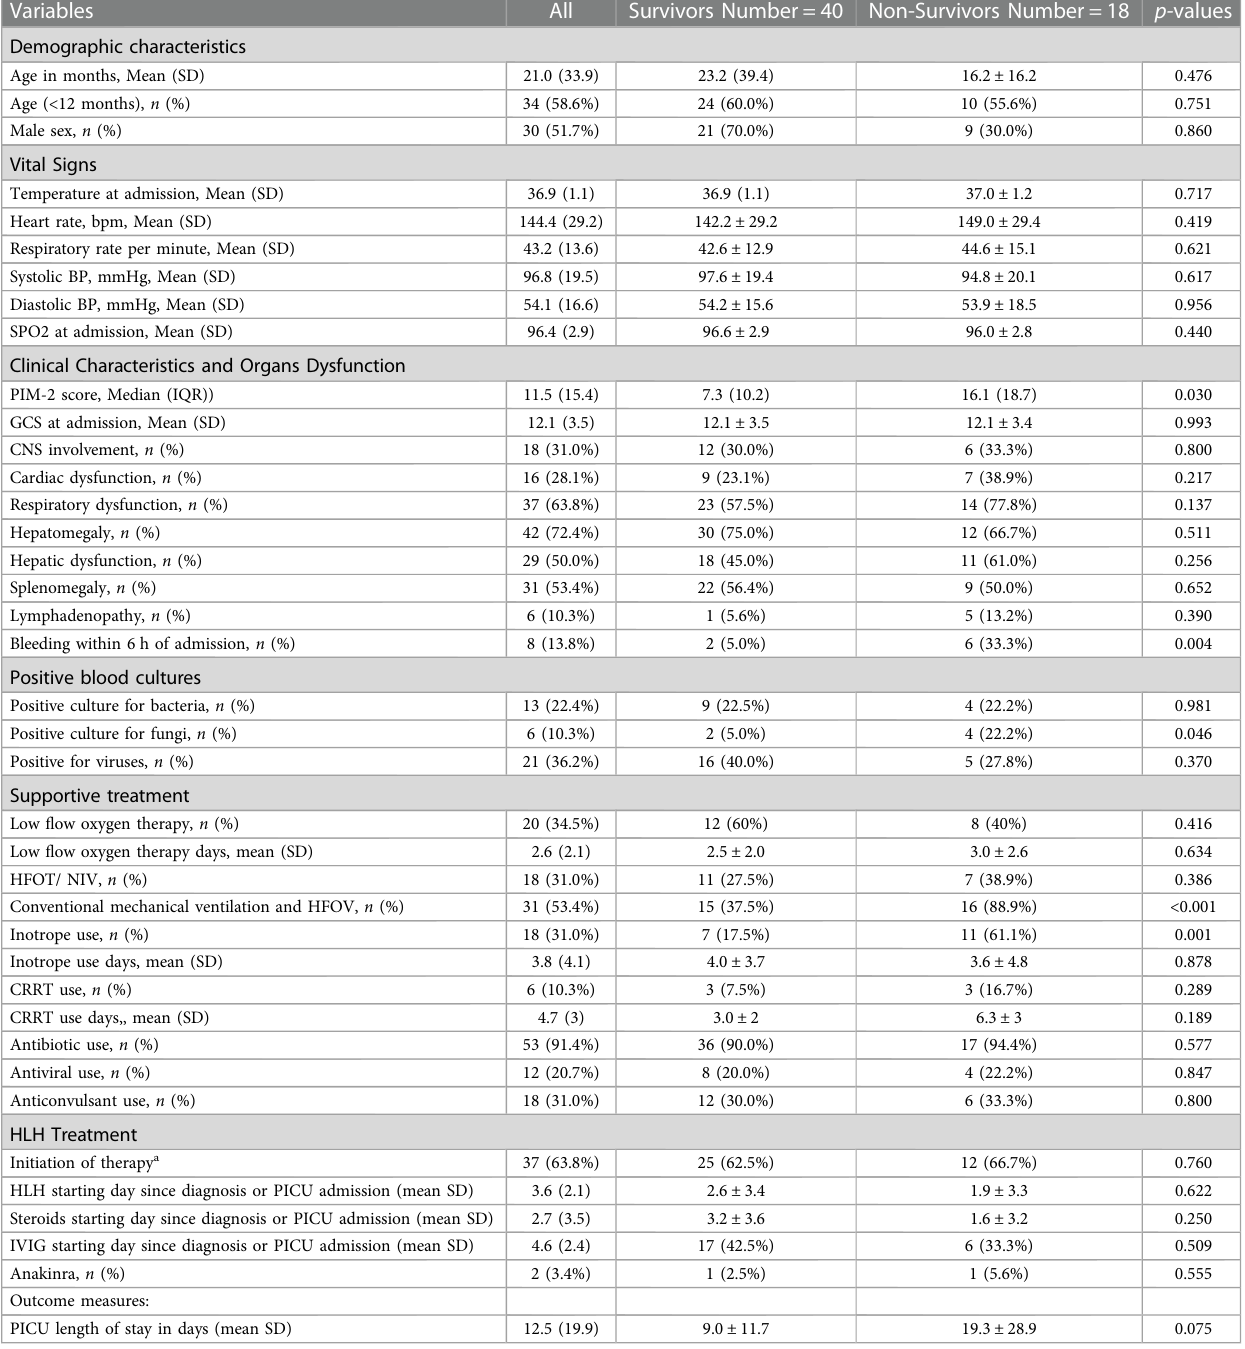
TABLE 2 Comparison of demographic and clinical characteristics between survivors and non-survivors. Variables All Survivors Number = 40 Non-Survivors Number = 18 p-